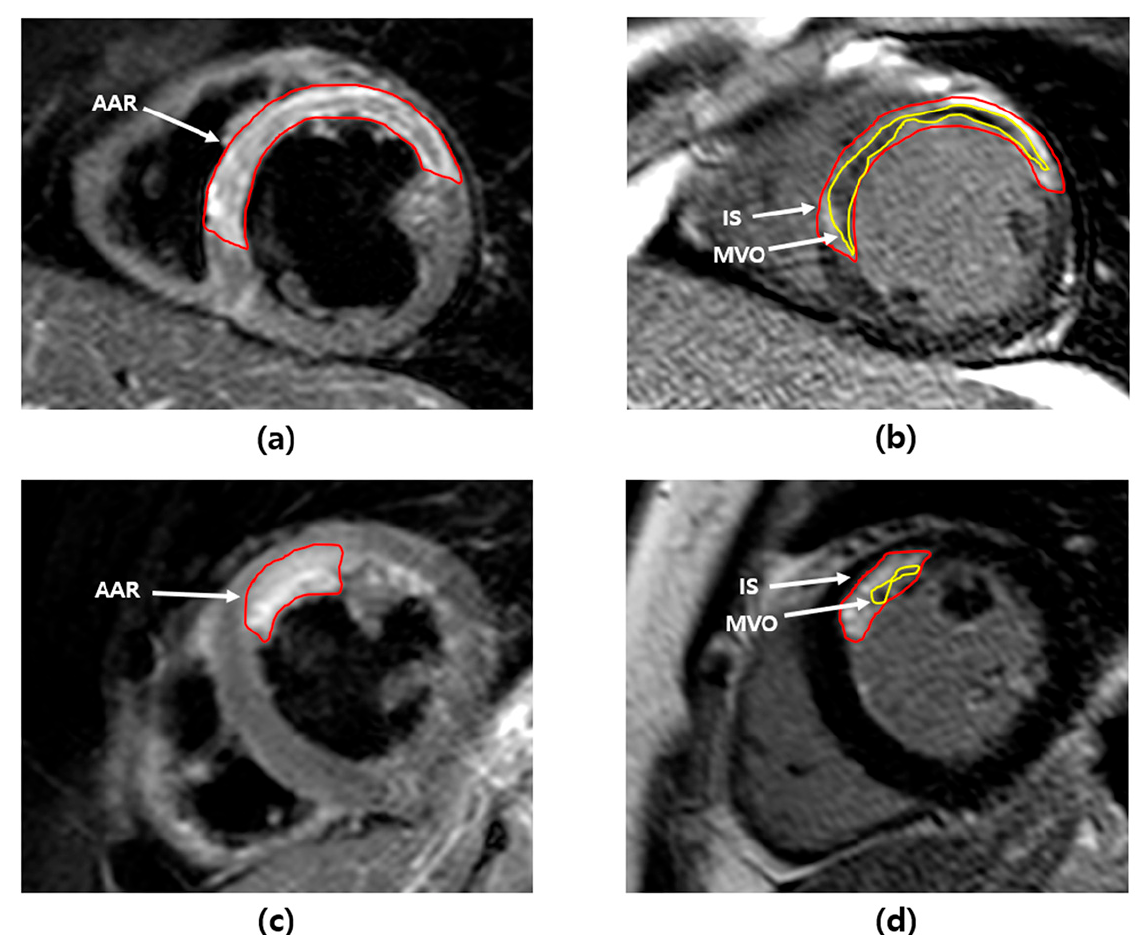
Figure 2. Cardiac magnetic resonance images of acute myocardial infarction. ( a ) AAR (55.2%) in T2-weighted image and ( b ) IS (44.8%) and MVO (10.4%) in late gadolinium hyperenhancement image of a patient in the high serum lactate group. ( c ) AAR (12.3%) in T2-weighted image and ( d ) IS (8.8%) and MVO (4.3%) in late gadolinium hyperenhancement image of a patient in the low serum lactate group. AAR = area at risk, IS = infarct size, MVO = microvascular obstruction.